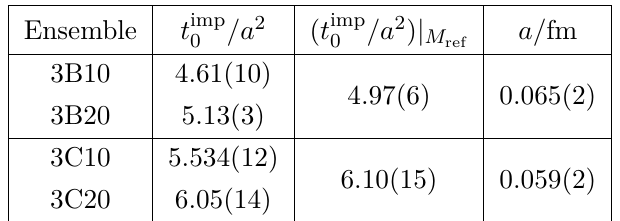
Table 2 . Results for the pion mass for the sea and the valence sector ( M s the pion decay constant, the PCAC mass in units of the twisted mass, and the chiral parameter, as defined in eq. (4.2). The “ L ” subscript indicates that the leading finite-volume effects estimated from ChPT have been taken into account [49, 50].